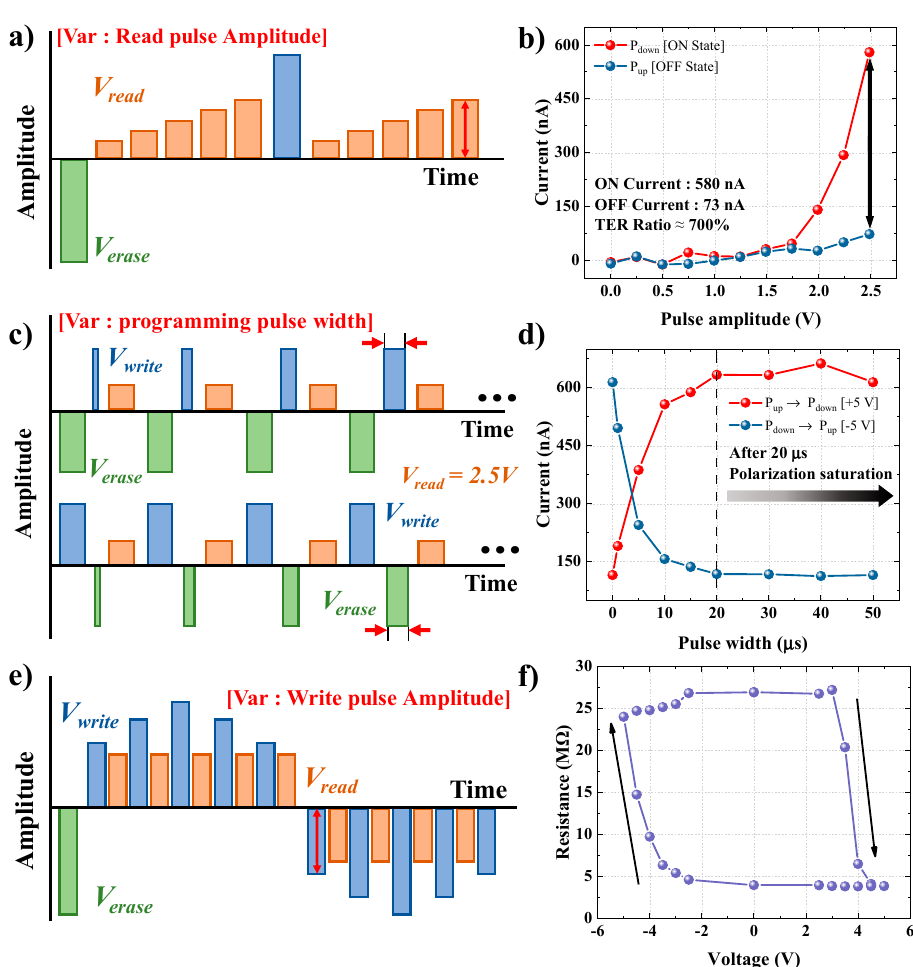
Figure 4. The pulse driving conditions analysis: ( a ) pulse scheme used to determine the read driving condition; ( b ) tunneling current depending on read voltage pulses with varying amplitudes and a pulse width of 100 µs; ( c ) pulse scheme used to determine the write driving condition; ( d ) tunneling current depending on the write voltage pulse; ( e ) pulse scheme used to obtain the resistance–voltage (R–V) hysteresis data; ( f ) R–V hysteresis loop.